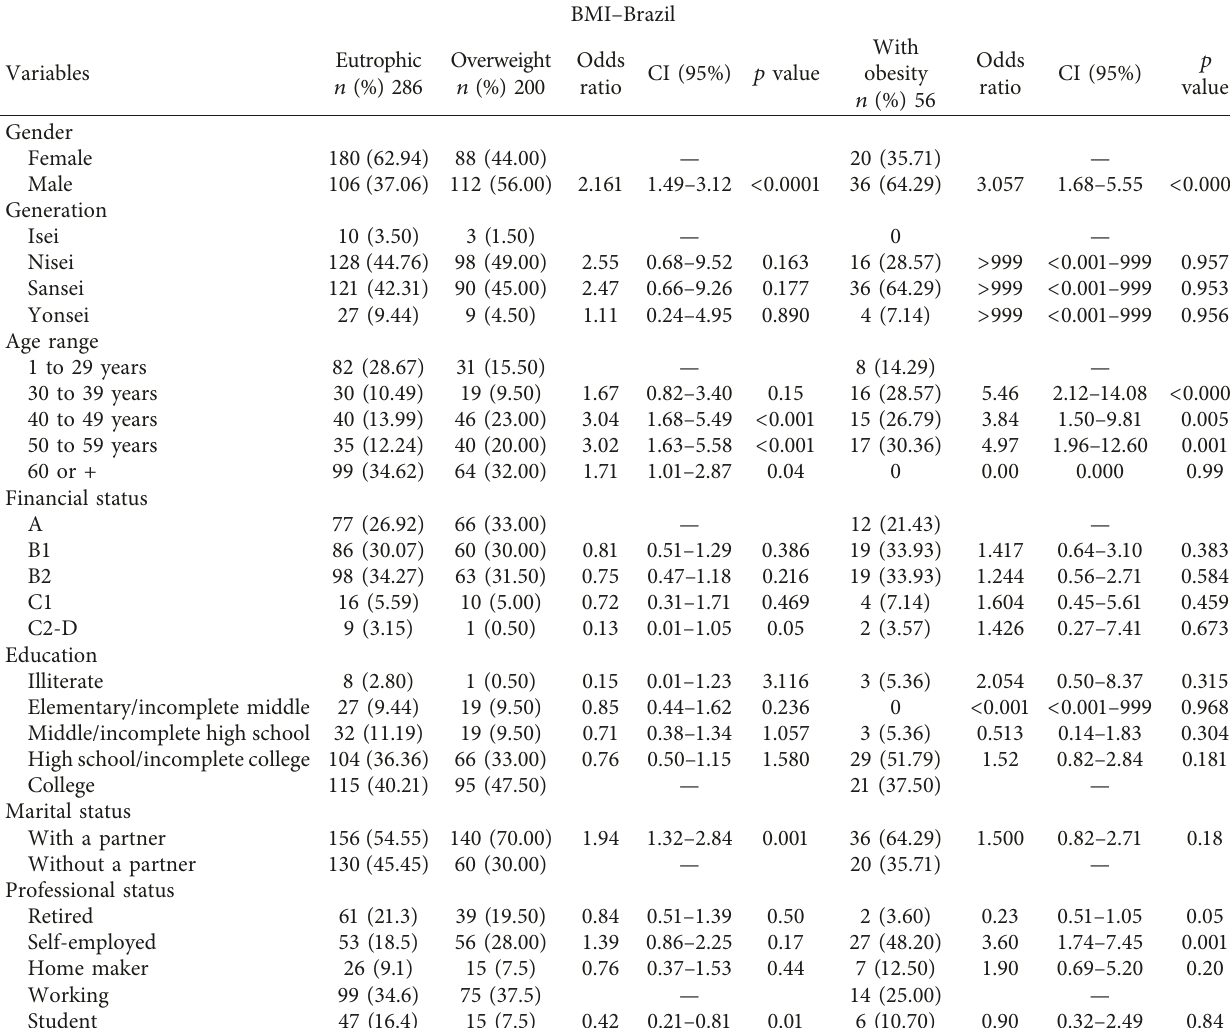
Table 1: Risk of overweight and obesity related to eutrophy in sociodemographic variables of Japanese-Brazilian individuals. Maring´a-PR, Brazil,